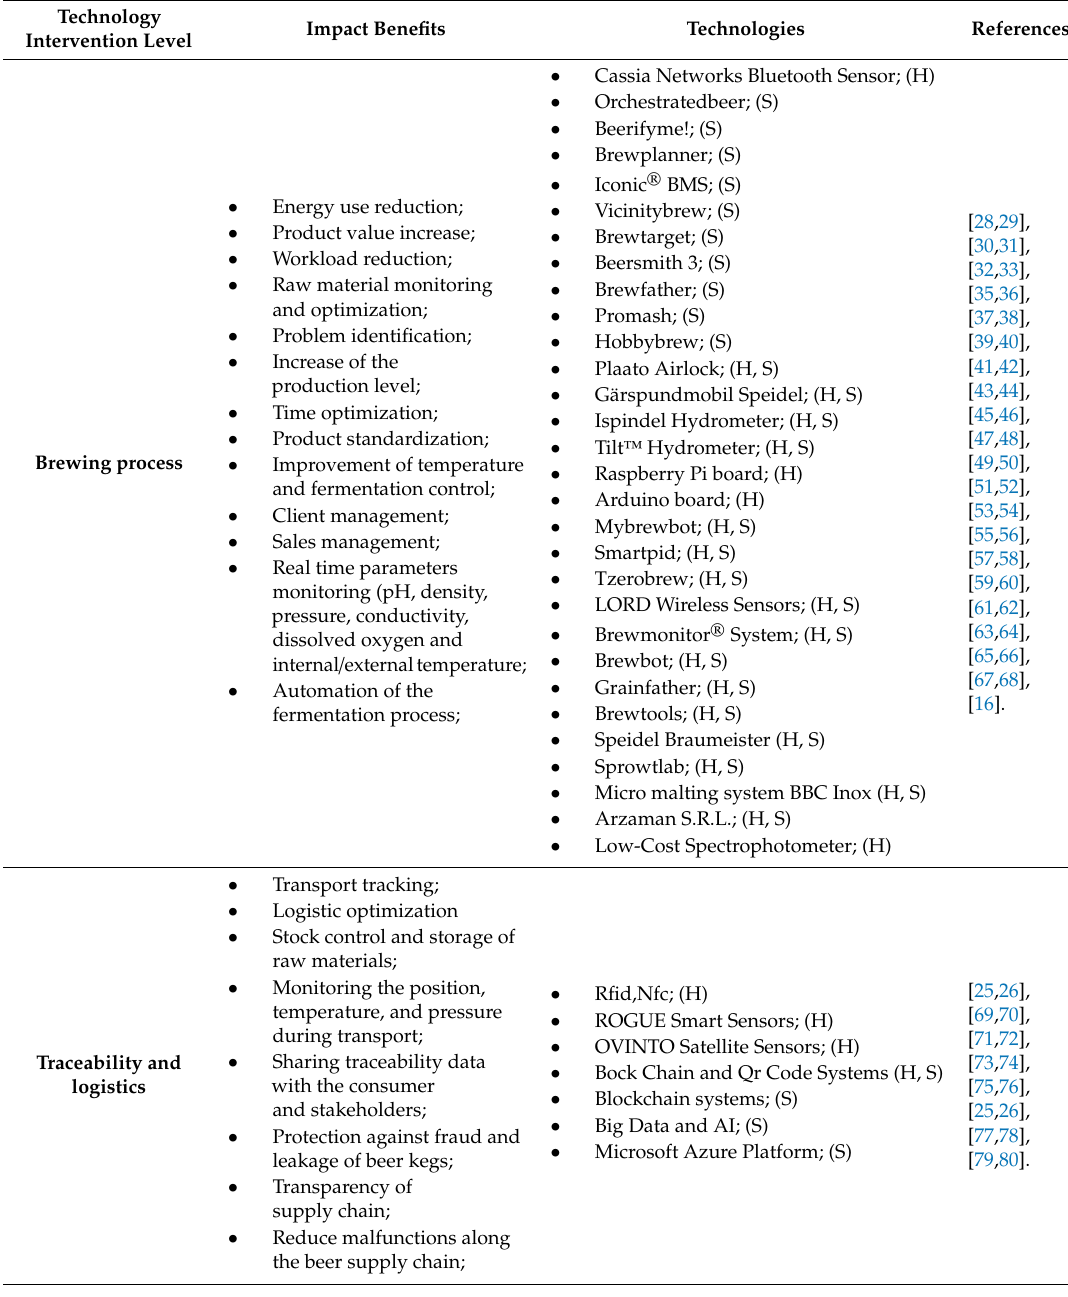
Table 2. Examples of Internet of Beer (IoB) use cases and their potential impact within the three reported macro areas on intervention. The letters H and S indicate Hardware and Software, respectively. Hardware is normally supplied with its own software, sometimes open for developers to produce their own